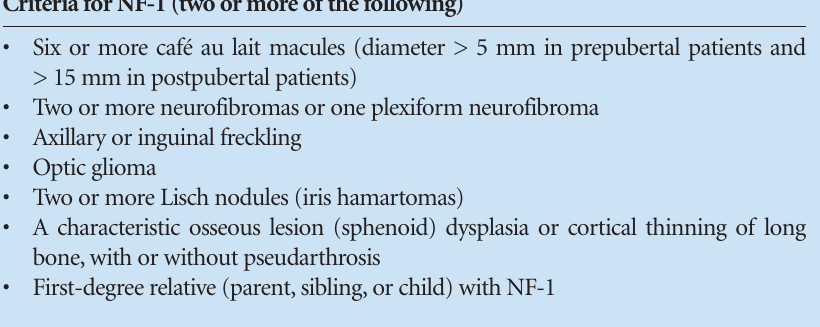
Table I. Diagnosis for neurofibromatosis